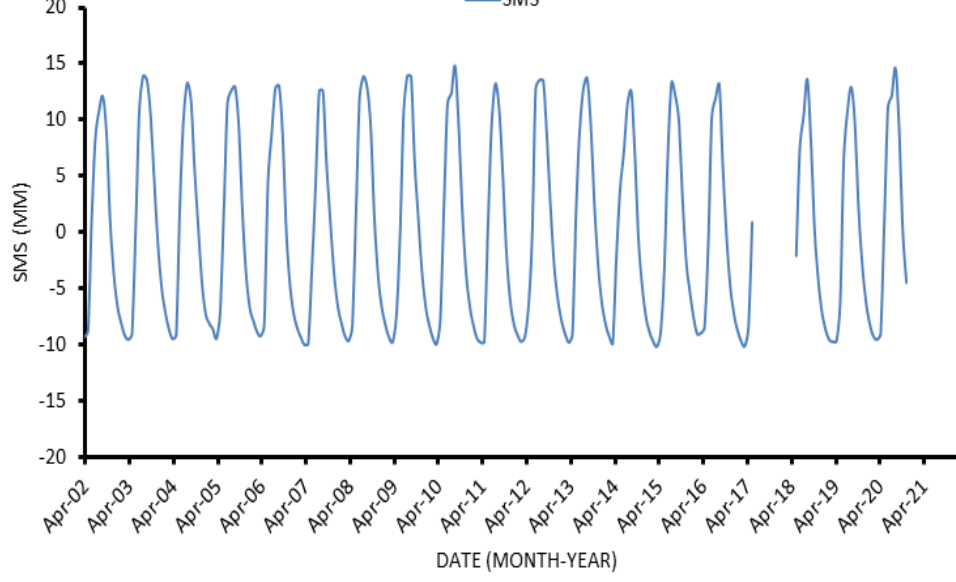
Figure 6. GLDAS-derived ∆ SMS in Senegal during the entire period. By subtracting the ∆ SMS trend from the ∆ TWS using following Equation (5). The trend in average ∆ GWS was estimated to be +0.63 ± 0.08 cm/yr during the entire period.